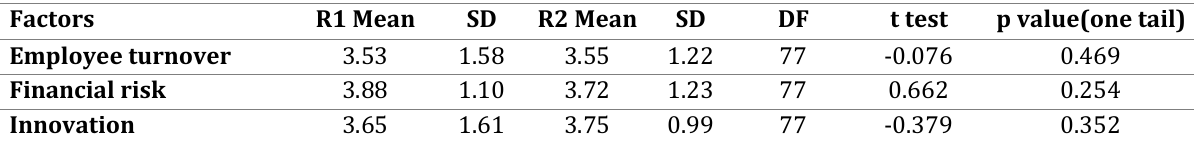
Table 3: Factors Re-evaluated between rounds Factors R1 Mean SD R2 Mean SD DF t test